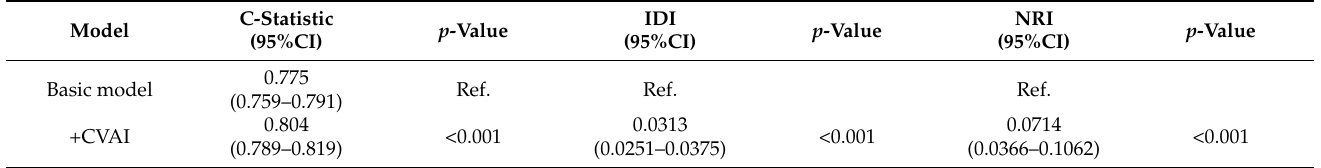
Table 4. Incremental predictive value of CVAI in risk assessment of CAS among